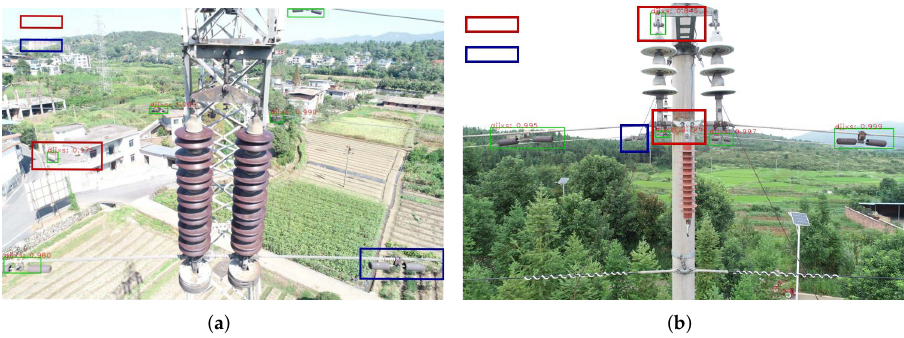
Figure 2. Examples of missing detection and false detection using Lim’s method [12] that is an improved version of Faster R-CNN for small-size object detection, where ( a , b ) are the two examples regarding of missing detection and false